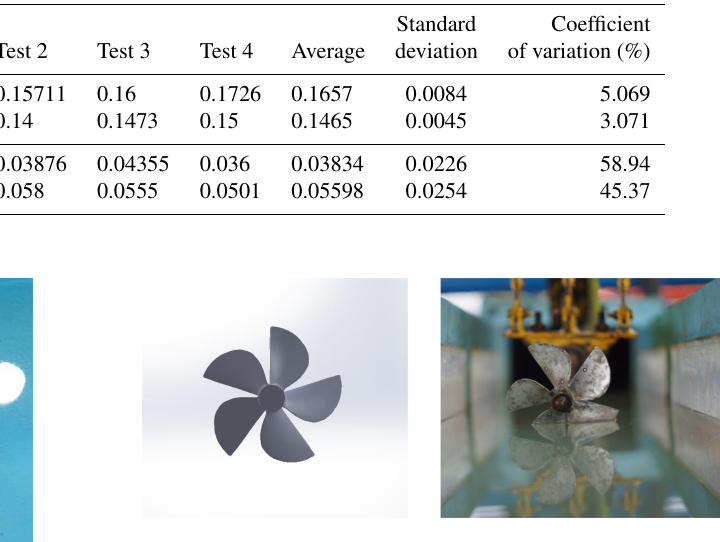
Figure 6. View of the propeller.